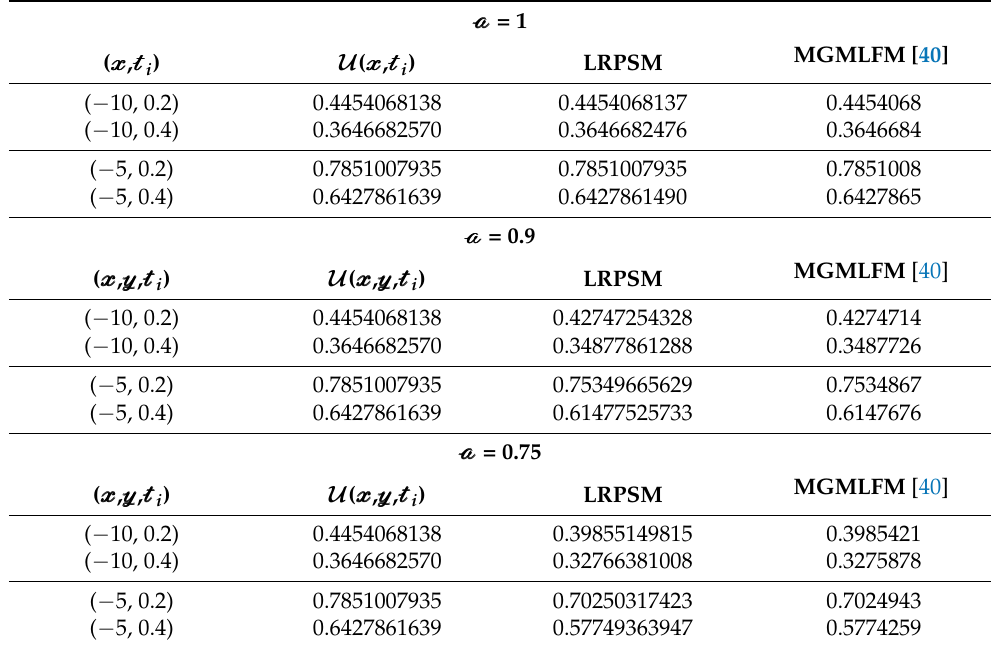
Table 9. Numerical comparisons for Example 2 at different values of 𝓍 , 𝒶 , and 𝓉 for the function U